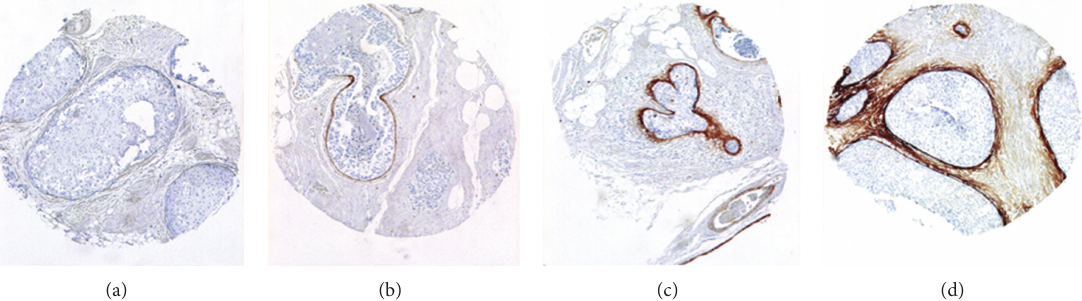
Figure 4: Tenascin-C scoring. Tenascin-C immunostaining; magnification 40 × . TMA slide details with tenascin-C expression 0 (a), 1+ (b), 2+ (c), and 3+